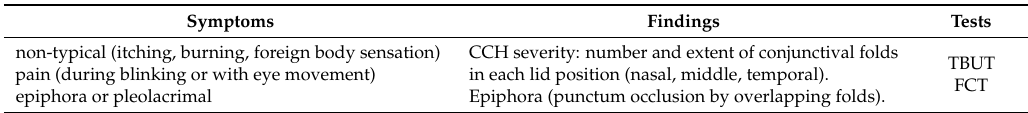
Table 1. Patient data documented on clinical examination.